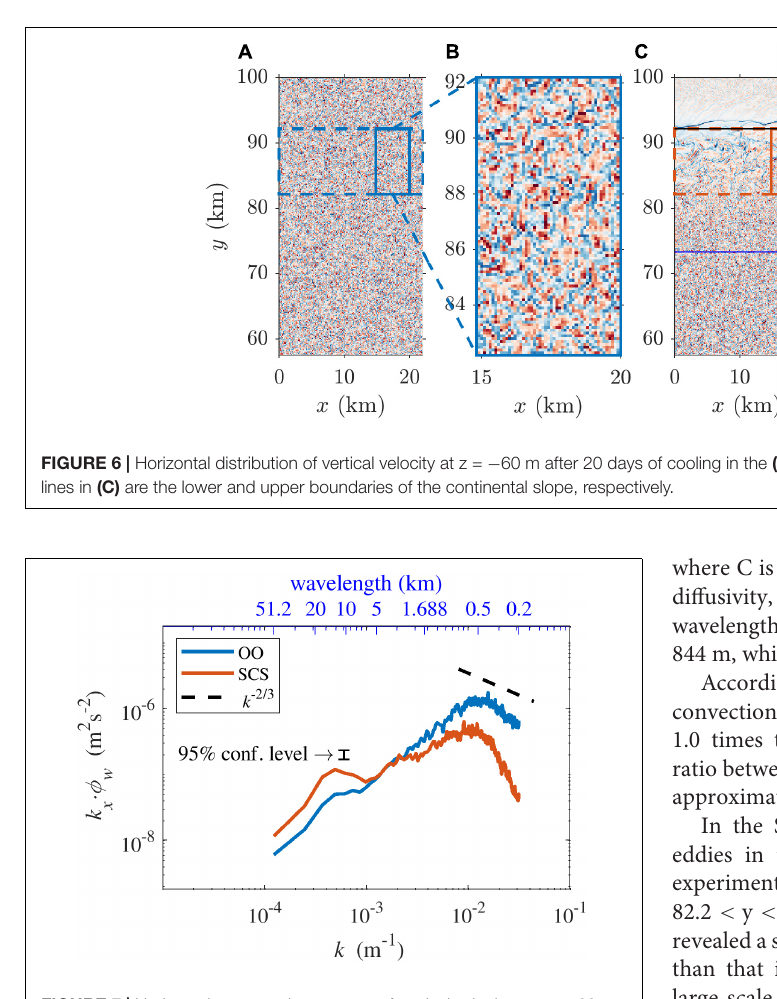
FIGURE 7 | Horizontal wavenumber spectra of vertical velocity at z = − 60 m in the OO (blue) and SCS (orange) experiments in the dashed blue and orange boxes of Figure 6 ,